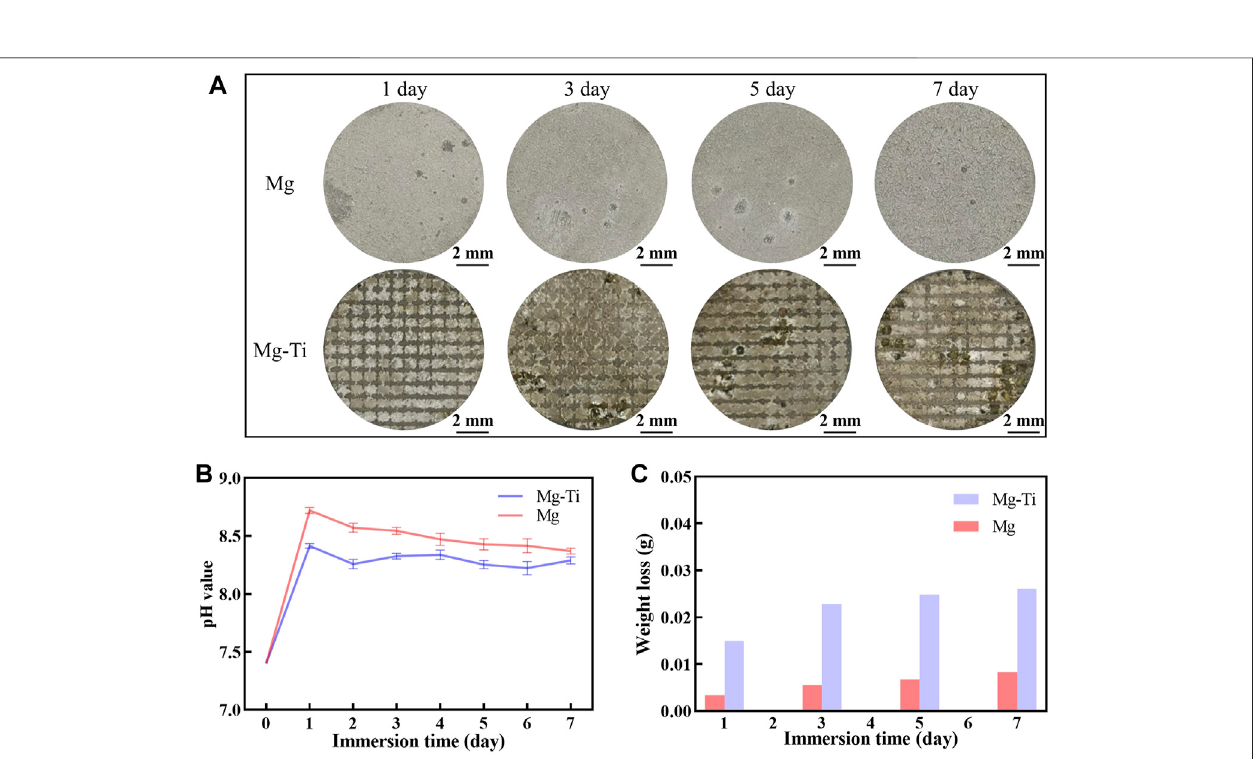
Frontiers in Bioengineering and Biotechnology |